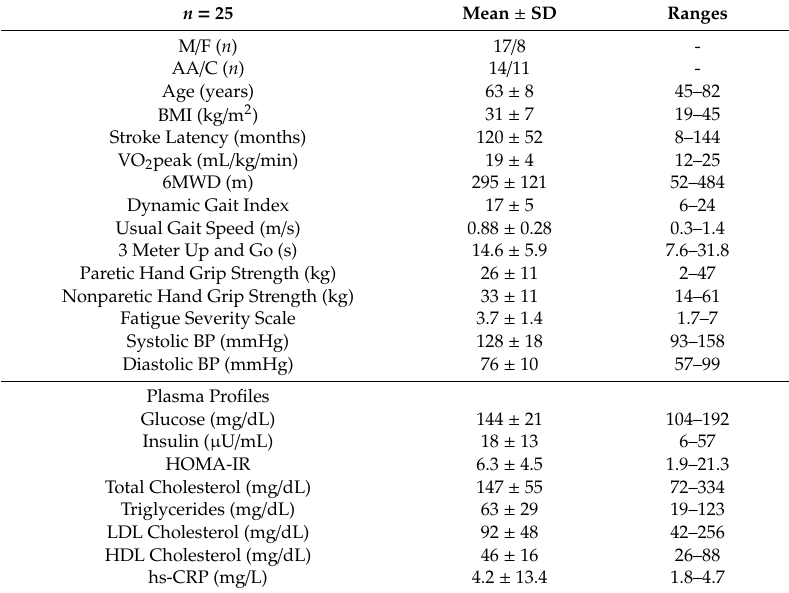
Table 1. Participant